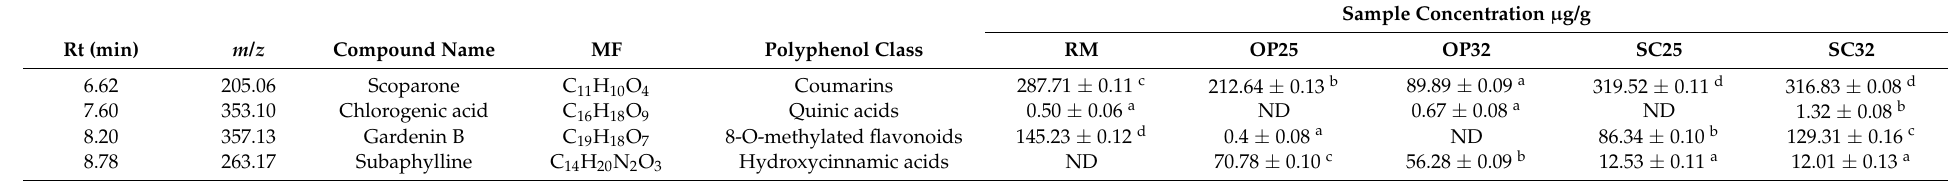
Table 3. Untargeted phenolic compounds of raw milk and amasi